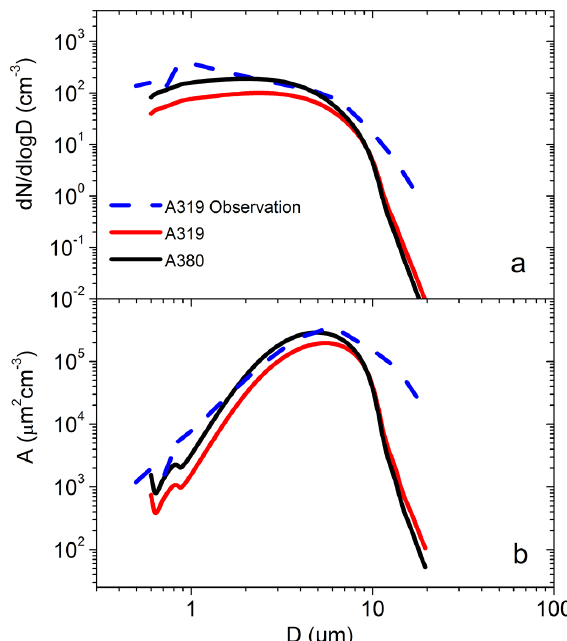
Fig. 6. Average particle size and planar-projected surface area dis- tributions from A319 (red) and A380 (black) aircraft contrails cal- culated with the EULAG-LCM model for ambient RHI 97%. The dashed blue line corresponds to the observed particle size and sur- face distribution. The particle size distributions have a similar shape in model and observation for D <10µm, with significant differences for D >10µm and higher total number concentrations in the obser- vation. The optical properties of the contrails are dominated by par- ticles with D ≈ 6µm.